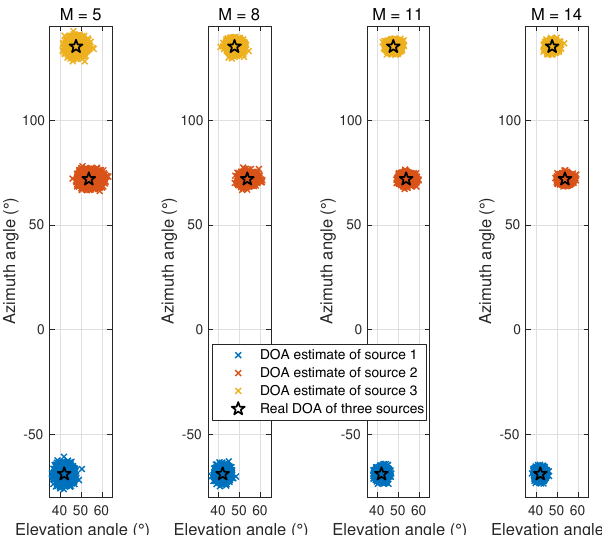
Figure 5. RMSE of 2D DOA estimation versus the number of sensors from 5 to 15. ( a ) RMSE of the elevation angle, ( b ) RMSE of the azimuth angle.